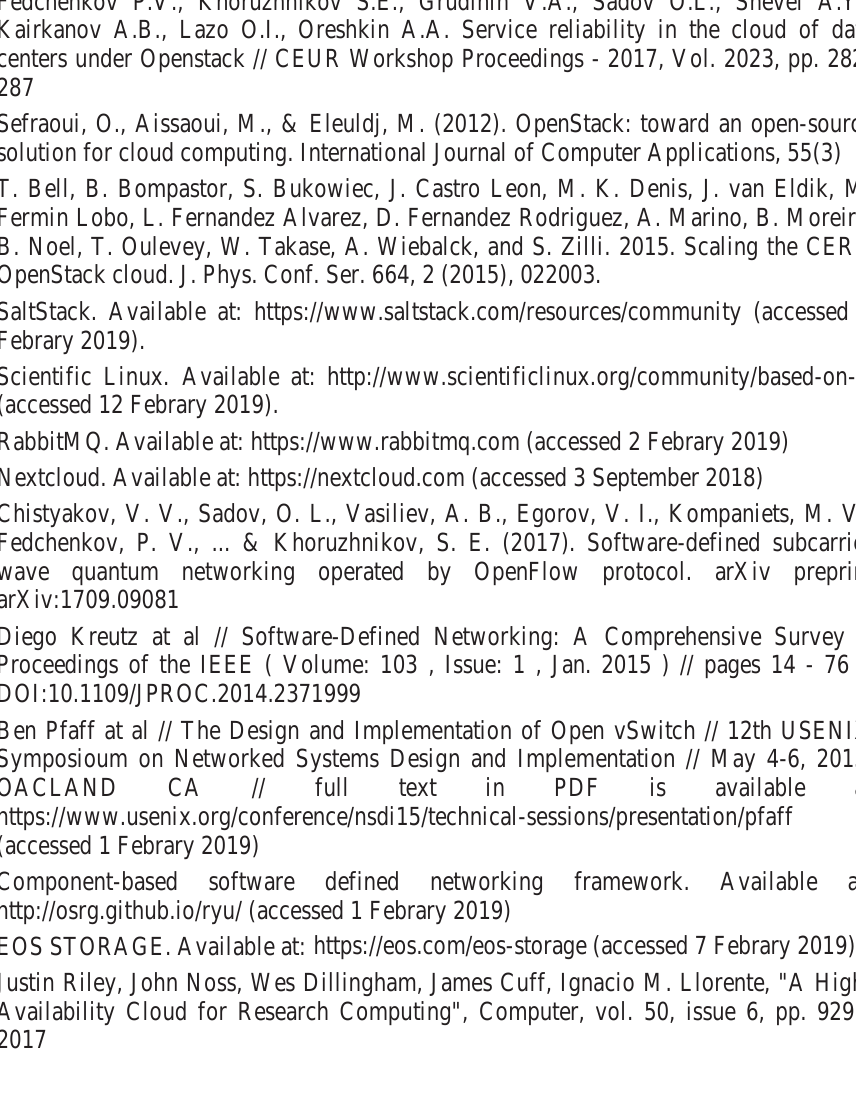
Fig. 6. Connectivity